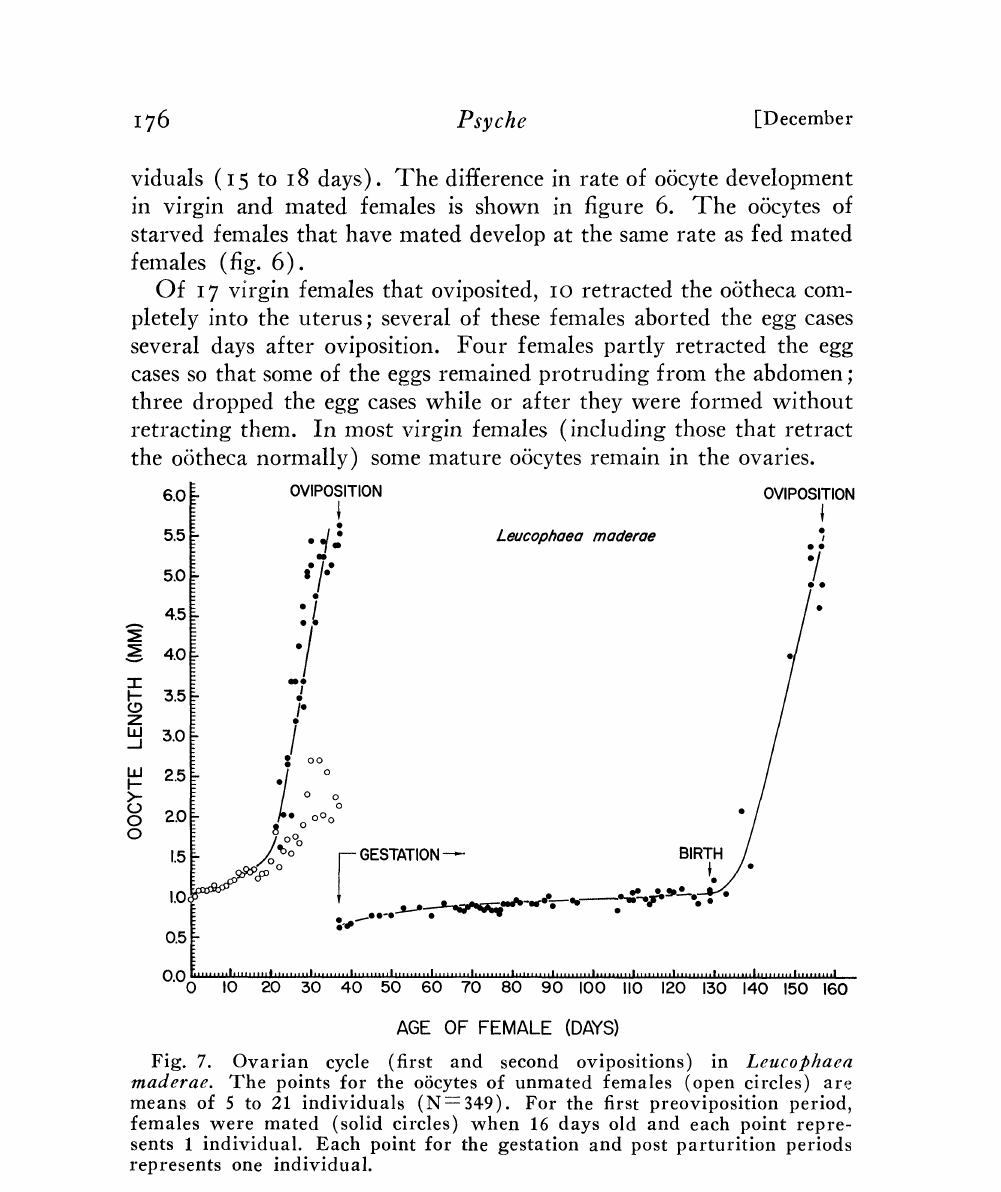
Fig. 7. Ovarian cycle (first and second ovipositions) in Leucophaea aderae. The points for the ocytes of unmated females (open circles) are means of to 21 individuals (N3ff9). For the first preoviposition period, females were mated (solid circles) when 16 days old and each point repre- sents individual. Each point for the gestation and post pa[tuEition pe[iods represents one individual Leucophaea aderae: At emergence the o6cytes of Lecophaea are o.97o.oz ram. (No). Mature o6cytes at ovulation are 5.56 o.z2 ram. (N2o: zo mated and zo virEin emales). The new